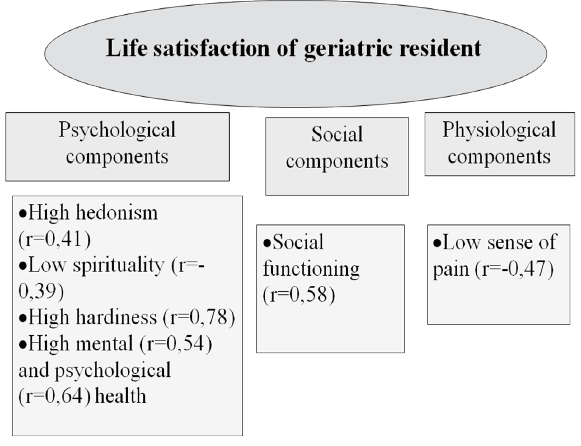
Fig. 3: The structure of life satisfaction of a geriatric